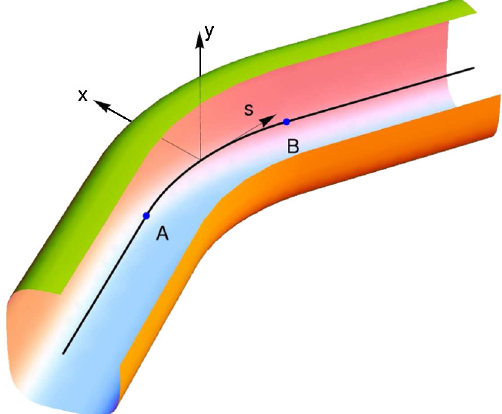
FIG. 1. (Color) A section of a vacuum chamber with toroidal bend between points A and B (a quarter of the pipe is cut out to expose the internal parts of the drawing). The thick black solid .*stupakov@slac.stanford.edu line is the central line of the pipe. Shown is a local coordinate † system at the position with the longitudinal coordinate equal to s